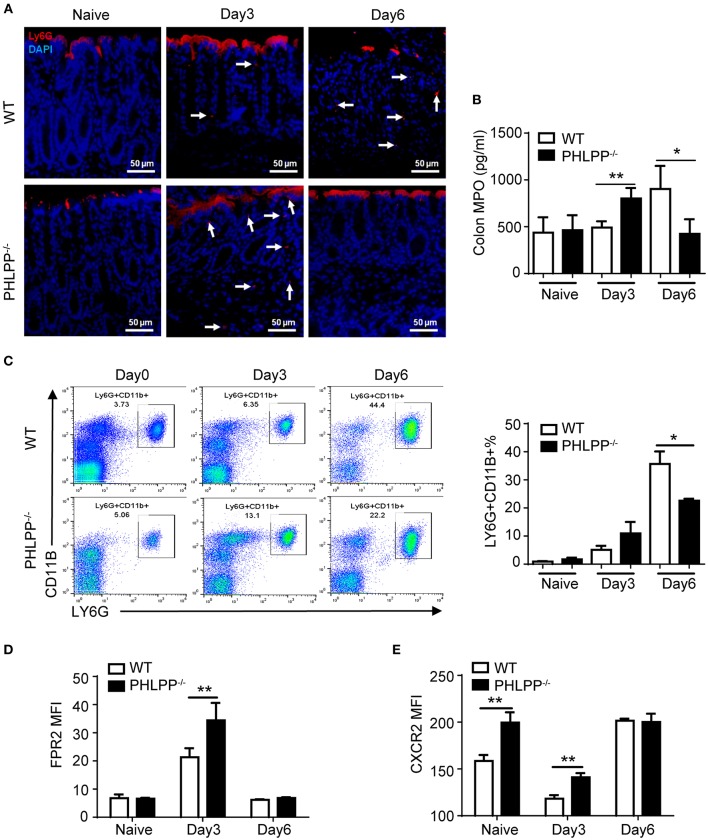
Enhanced neutrophil activation due to PHLPP deficiency. (A) Representative images of immunohistological staining of neutrophils (LY6G+) in colon tissues of DSS-treated WT and PHLPP−/− mice on day 0, 3, and 6 during the process of experimental colitis. (B) Colon tissues were collected on day 0, 3, and 6 cultured overnight. Supernatant was collected for detection of MPO by ELISA. (C) Flow cytometry analysis of peripheral neutrophils (gated on CD11B+ LY6G+) harvested on day 0, 3, and 6 during the process of experimental colitis. (D) FPR2 expression on peripheral neutrophils (gated on LY6G+ CD11B+) from WT and PHLPP−/− mice on day 0, 3, and 6 post DSS challenges via flow cytometry. (E) CXCR2 expression on peripheral neutrophils (gated on LY6G+CD11B+) from DSS-treated mice on day 0, 3, and 6 post DSS challenges via flow cytometry. For mouse number in each group, n ≥ 4. *p < 0.05, **p < 0.01.